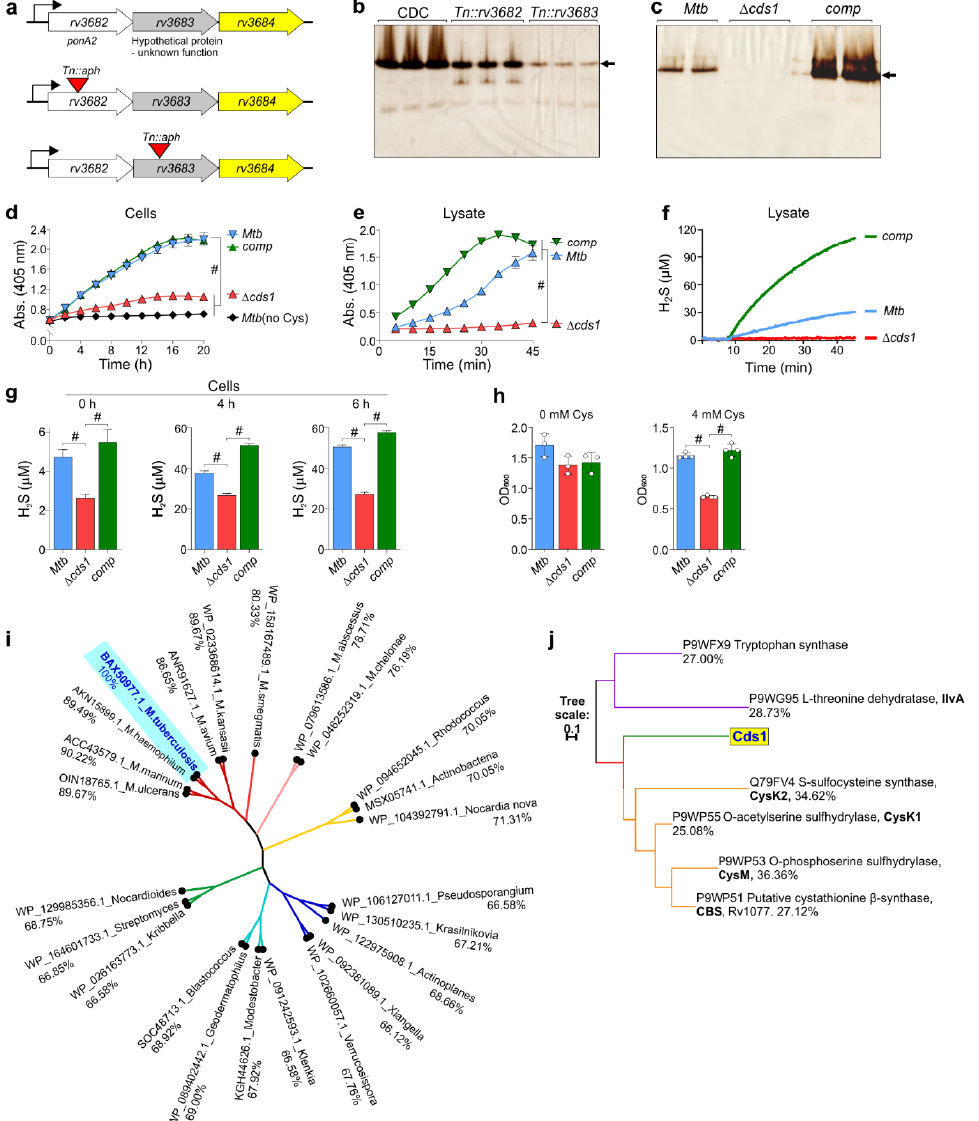
Figure 3. Deletion of rv3684 in Mtb reduces H 2 S production. ( a ) The proposed operonic location of rv3684 . Bacterial lysates resolved on native polyacrylamide gels (PAGE) were assayed for H 2 S production using an in-gel BC assay in ( b ) Mtb CDC1551, CDC Tn::rv3682 , and CDC Tn::rv3683 ( n = 3) and ( c ) Mtb H37Rv, ∆ cds1 , and comp , ( n = 2). The arrow indicates the Cds1 band. ( d ) H 2 S production in intact Mtb H37Rv, ∆ cds1, and comp cells ( n = 8) and ( e ) lysates ( n = 3–4) using the BC method (in the presence of 10 μM PLP and 20 mM L-Cys). ( f ) H 2 S production in Mtb H37Rv, ∆ cds1 , and comp lysates and ( g ) cells at 0, 4, and 6 h using the Unisense amperometric microsensor. ( h ) Growth (OD 600 ) of Mtb H37Rv, ∆ cds1 , and comp cultures after 8 days in 0 and 4 mM L-Cys, ( n = 3–4). ( i ) Phylogenetic tree of Cds1 (Rv3684) homologs in different Mycobacterium sp. and other bacteria (NCBI protein accession number) and >65% amino acid identity with Cds1. ( j ) Putative sulfur metabolism proteins in Mtb H37Rv (NCBI protein accession number and the percent identity with Cds1 provided). Representative experiments are shown in each panel, each experiment was repeated at least twice. Data represent the mean ± SD or ± SEM (panel ( e )) from the indicated n (number of replicates per data set). ( f ) The microsensor reading for a buffer baseline for a few min followed by addition of the lysate to initiate the reaction. ( g ) At least 10–20 amperometric measurements were taken for each strain and condition once the Unisense microsensor readings stabilized. Statistical analyses were performed using GraphPad Prism 8.4.3. One-way ANOVA with Dunnett’s multiple comparisons test was used to determine statistical significance. # p <